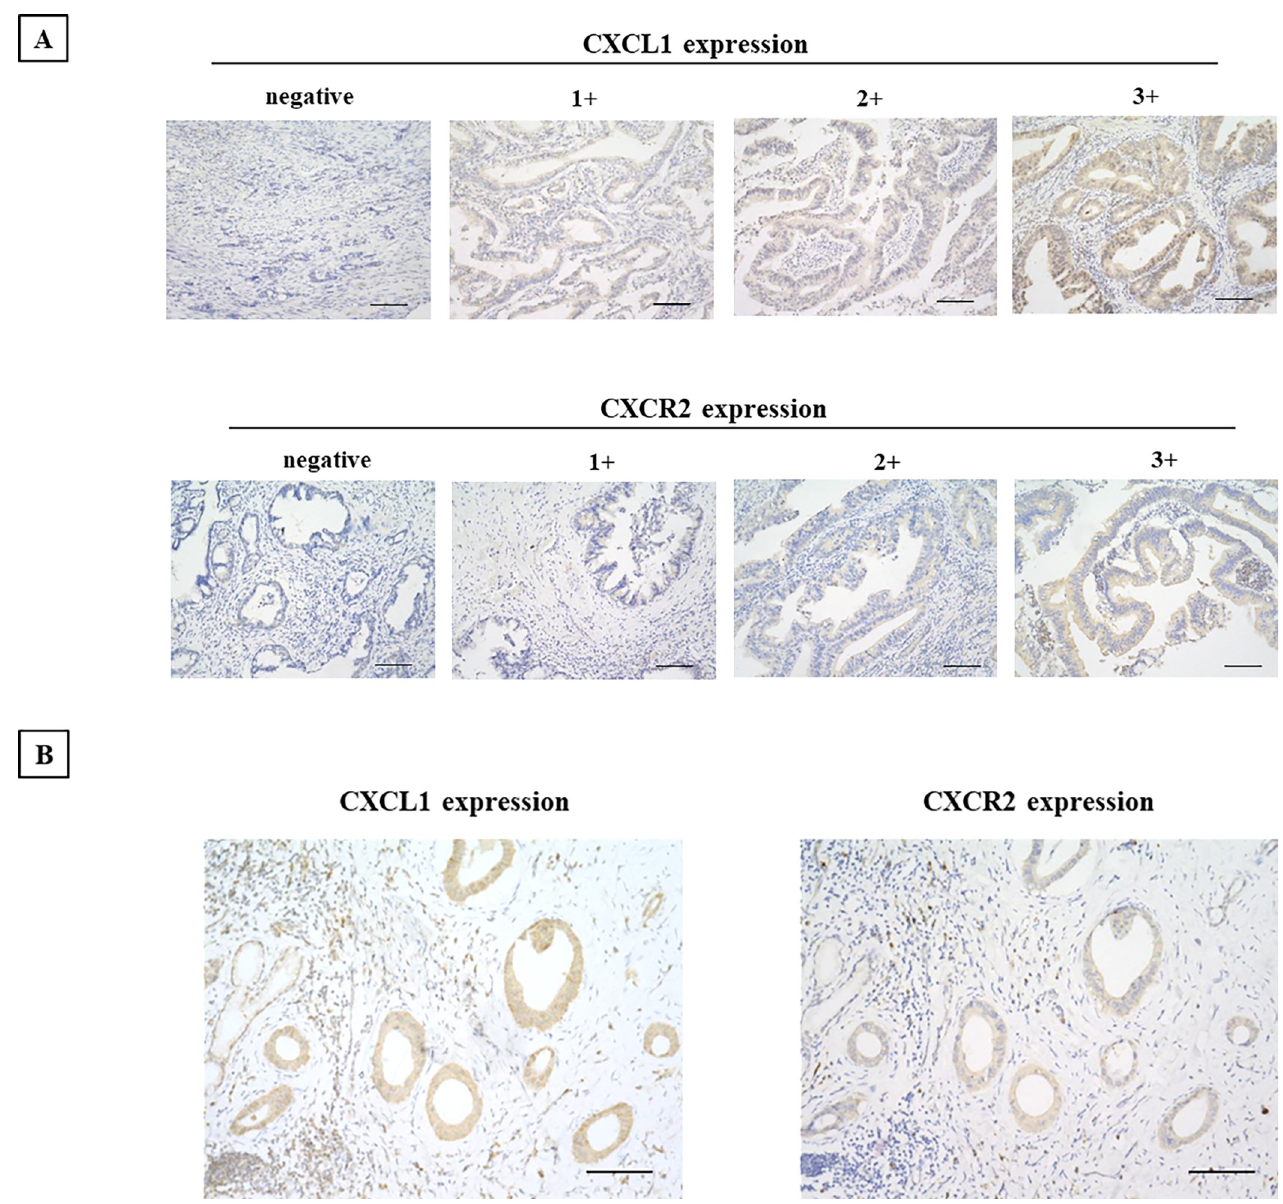
Fig 2. Representative immunostaining images of CXCL1 and CXCR2 expression. A, CXCL1 was expressed in CCA cells. CXCR2 was observed at both the cell membrane and the cytoplasm. Intensity score: 0, negative; 1+, weakly positive; 2+, positive; 3+. Bar: 100 μ m. B, CXCL1 and CXCR2 expression in a case. Bar: 100 μ